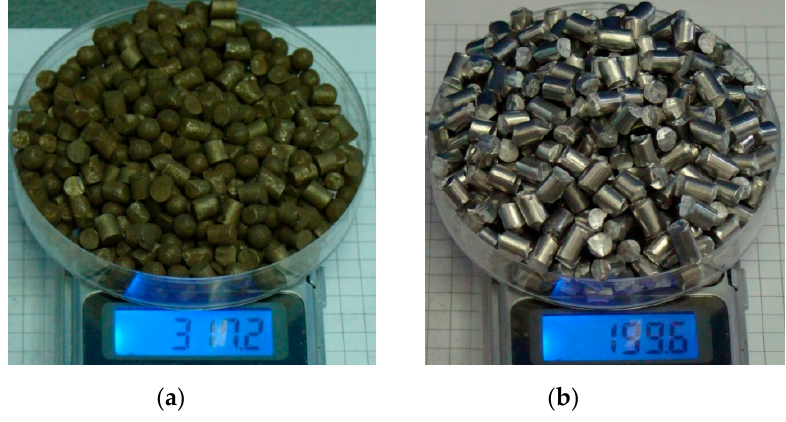
Figure 3. The appearance of metal-loading granules: ( a ) iron granules; ( b ) aluminum granules.